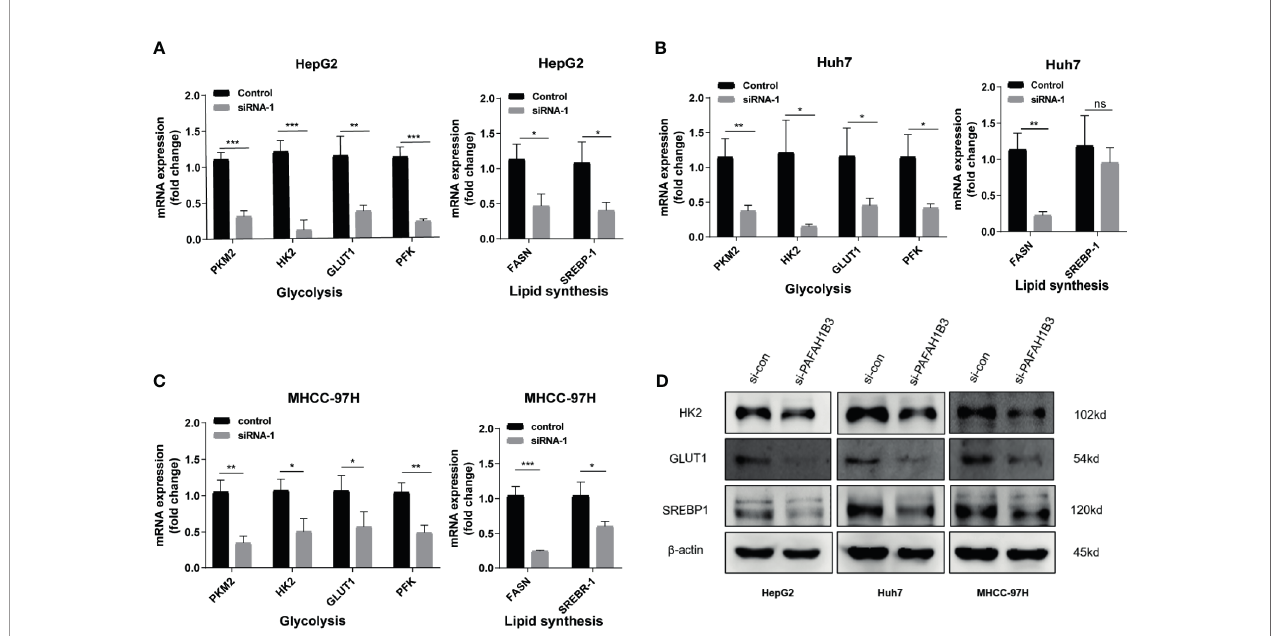
FIGURE 6 | PAFAH1B3 downregulates glycolysis and lipid synthesis signaling pathways. (A – C) Analysis of glycolysis-and lipid synthesis-related genes (PKM2, HK2, GLUT1, PFK, FASN and SREBP-1) in HepG2 Huh7 and MHCC-97H cells after silencing PAFAH1B3 for 48 h. (D) Analysis of glycolysis-related key enzymes and lipid synthesis-related transcription factor (HK2, GLUT1 and SREBP-1) in HCC cells by Western blot after silencing PAFAH1B3 for 48 h. *p < 0.05; **p < 0.01; ***p < 0.001. NS, no signi fi